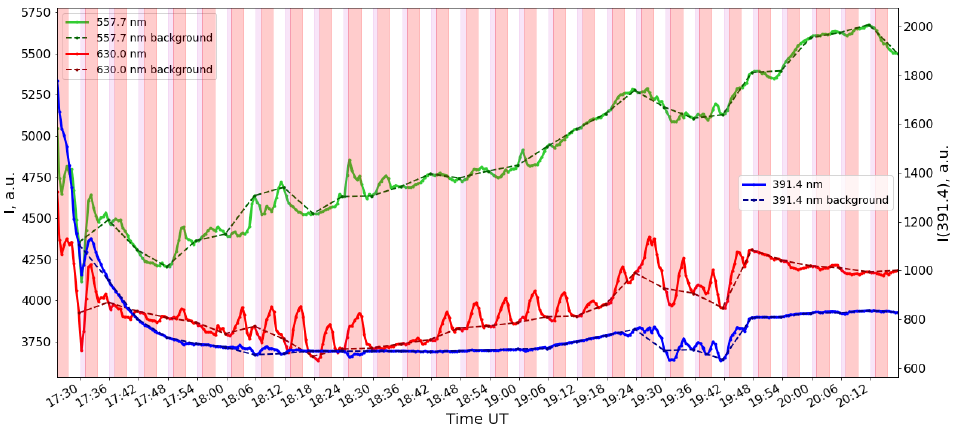
Figure 2. Data from the 557.7nm, 630nm, and 391.4nm photometer channels. The data are integrated over the CCD camera exposure time (27s). The dotted line shows the trend for the corresponding photometer channels. The SURA pulse emission and continuous pumping periods are highlighted in gray and pink colors, respectively, as well as in the following